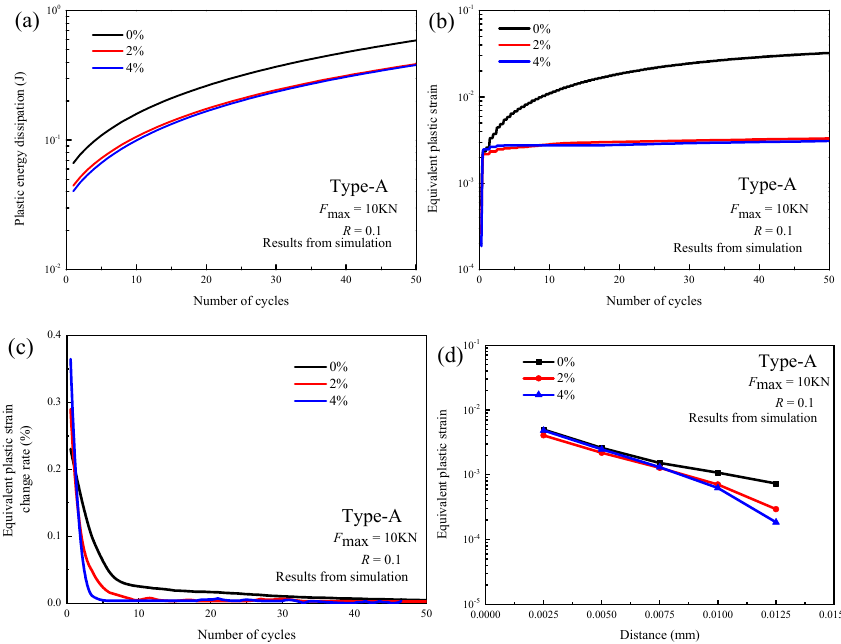
Figure 6. Effect of pre-strain on crack growth behavior (Type-A crack, crack length of 3.5 mm): ( a ) variation of plastic strain energy; ( b ) PEEQ at 5 µ m of crack tip under 50 cycles; ( c ) variation of PEEQ change rate; ( d ) variation of PEEQ distribution near crack tip after the first cycle.